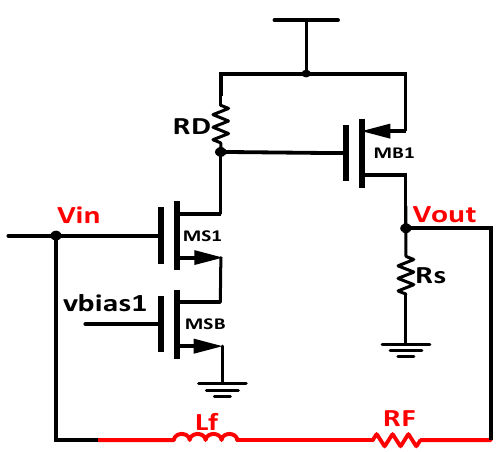
Figure 8. Single end of the TIA.